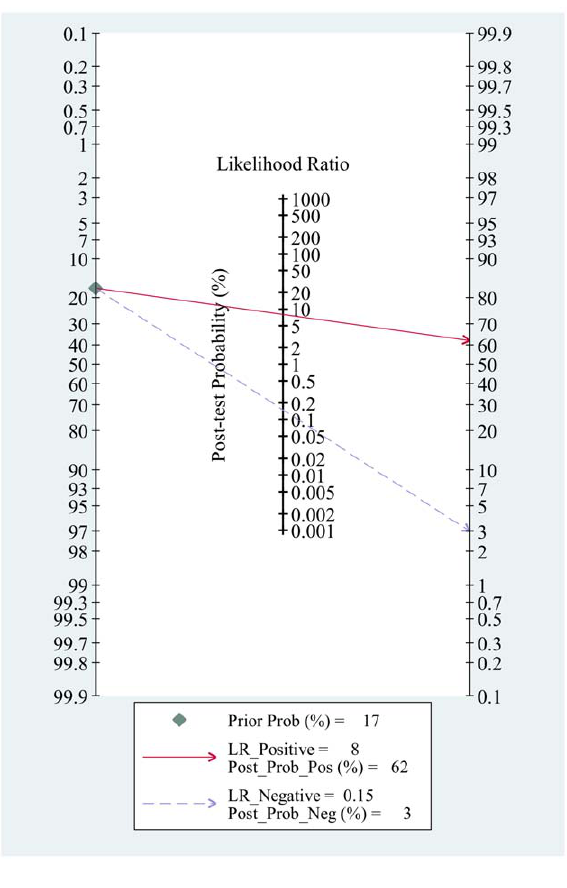
Figure 6. Fagan plot analysis to evaluate the clinical utility of BLAF-GM test.